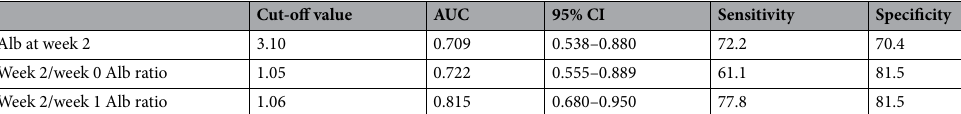
Table 2. Receiver operating characteristic analysis for prediction of treatment failure based on serum albumin level and ratio during the 3-month follow-up period after reaching the tacrolimus high trough level. AUC, area under the curve; CI, confidence interval; Alb,